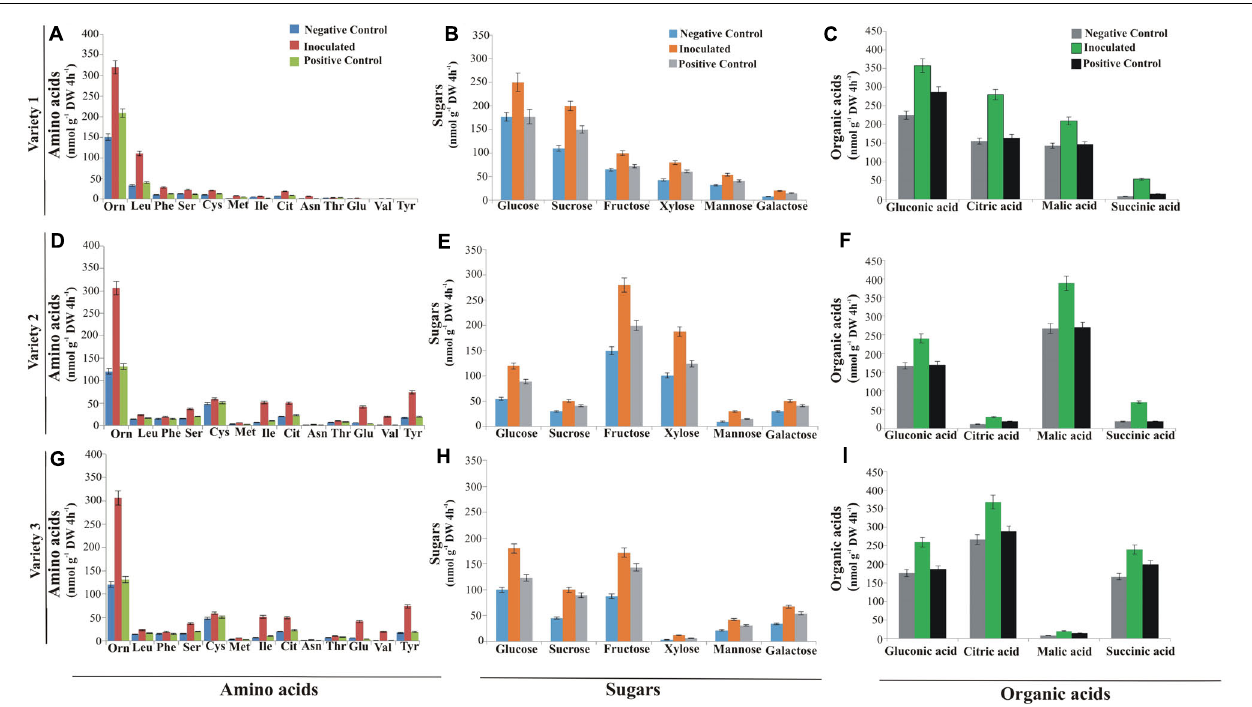
FIGURE 5 | Differential root exudates of wheat varieties grown hydroponically. Root exudates of variety 1 amino acids (A) , sugars (B) and organic acids (C) . Root exudates of variety 2 amino acids (D) , sugars (E) , and organic acids (F) . Root exudates of variety 3 amino acids (G) , sugars (H) , and organic acids (I) . Root exudates were collected over a period of 4 h. Data are the mean of six biological replicates, while bars represent mean standard error; n = 4. Orn, Ornithine; Leu, Leucine; Phe, Phenylalanine; Ser, Serine; Cys, Cystine; Met, Methionine; Ile, Isoleucine; Cit, Citrulline; Asn, Asparagine; Thr, Threonine; Glu, Glutamine; Val, Valine; and Tyr, Tyrosine; Varieties 1, Faisalabad-08; Variety 2, Fakhr-e-Sarhad; Variety 3, Benazir-13; DW, dry